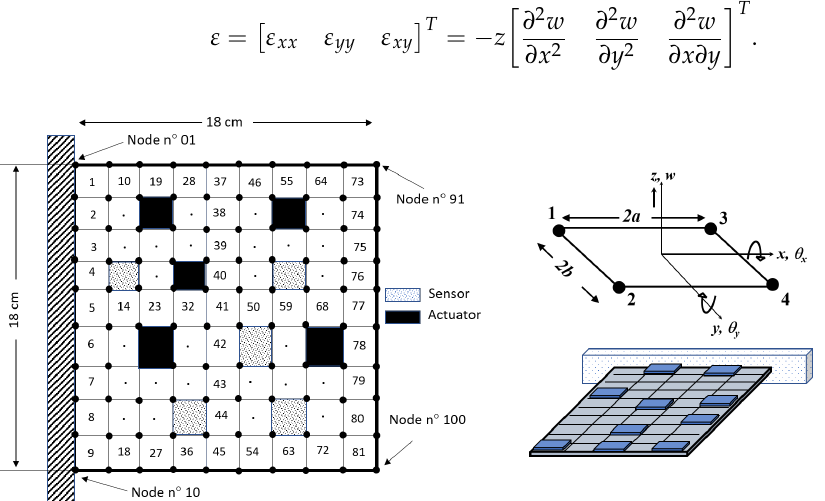
Figure 1. The smart plate with distributed thermo-piezoelectric patches and the four-noded Kirchhoff element with mechanical degrees of